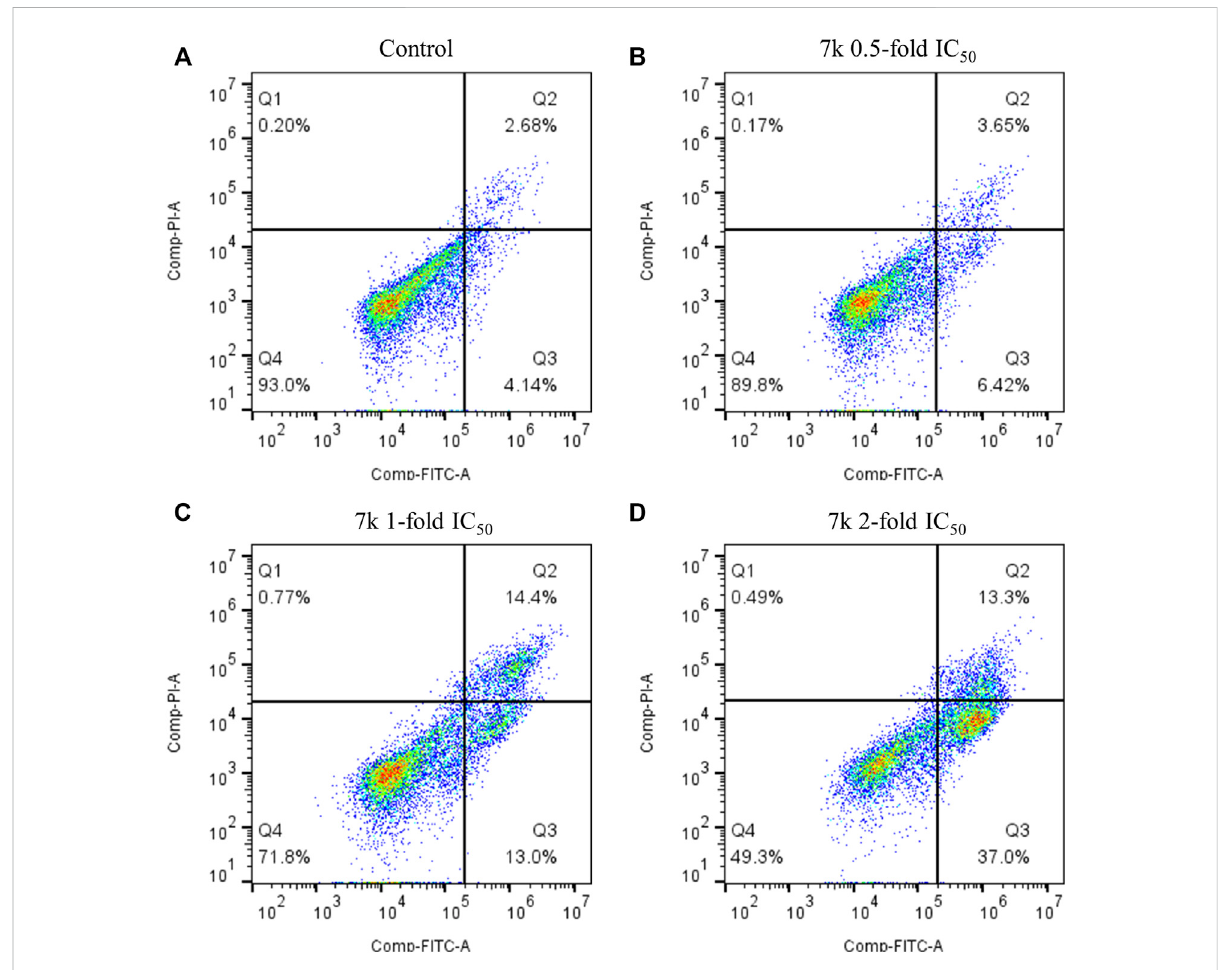
FIGURE 6 Effect of 7k on HeLa cell apoptosis. Cells were harvested and stained with Annexin-V/PI for analysis after treatment with different concentrations of compound 7k for 48 h. (A) Control; (B) 7k , 0.5-fold IC 50 ; (C) 7k , 1-fold IC 50 ; (D) 7k , 2-fold IC 50 .